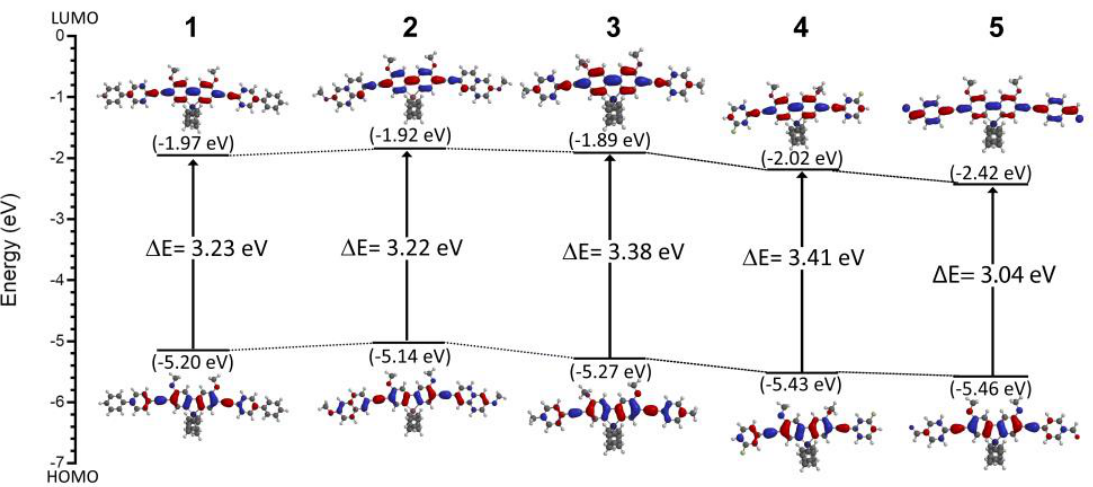
Figure 3. HOMO-LUMO gap of compounds 1 – 5 , determined from Spartan ’18: B3LYP-6-31G* with Figure 3 . HOMO-LUMO gap of compounds 1 - 5, determined from Spartan ’18: B3LYP -6-31G* with dielectric constant set to 8.93 (DCM). dielectric constant set to 8.93 (DCM).